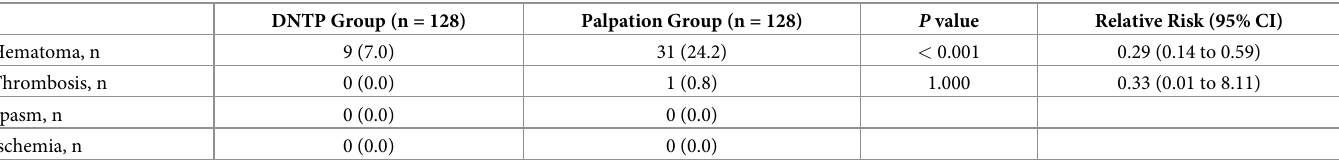
Table 3. Complications after radial artery cannulation.